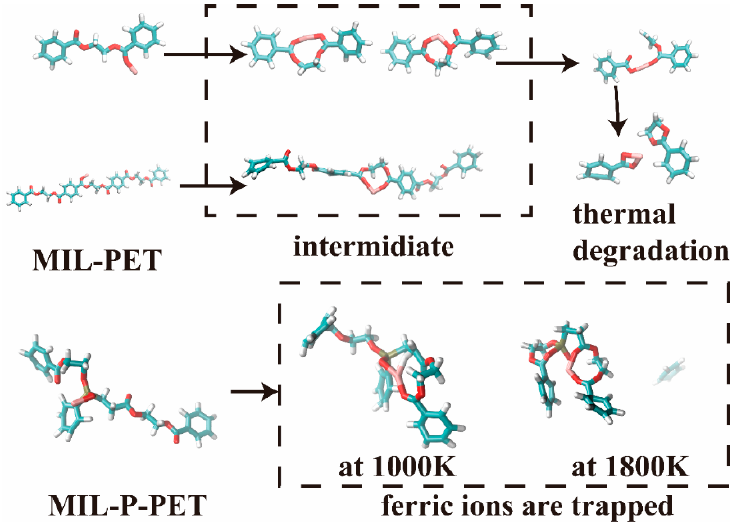
Figure 11. The representative video clips in quantum chemistry molecular dynamics of MIL − PET and MIL − P − PET at 727 °C (1000 K) and 1527 °C (1800 K).